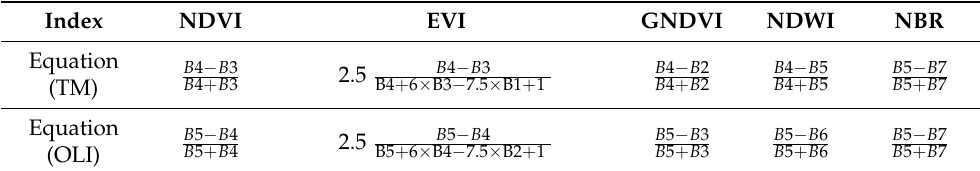
Table 1. Spectral Index